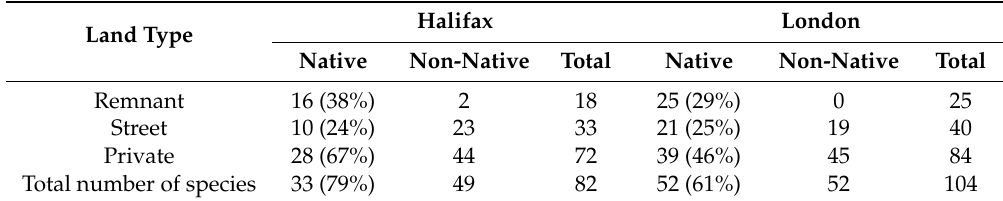
Table 3. Combined species richness and raw counts of native and non-native species on each land type for both cities. Percentages represent proportion of native species sampled out of the total number of native species found in the province.